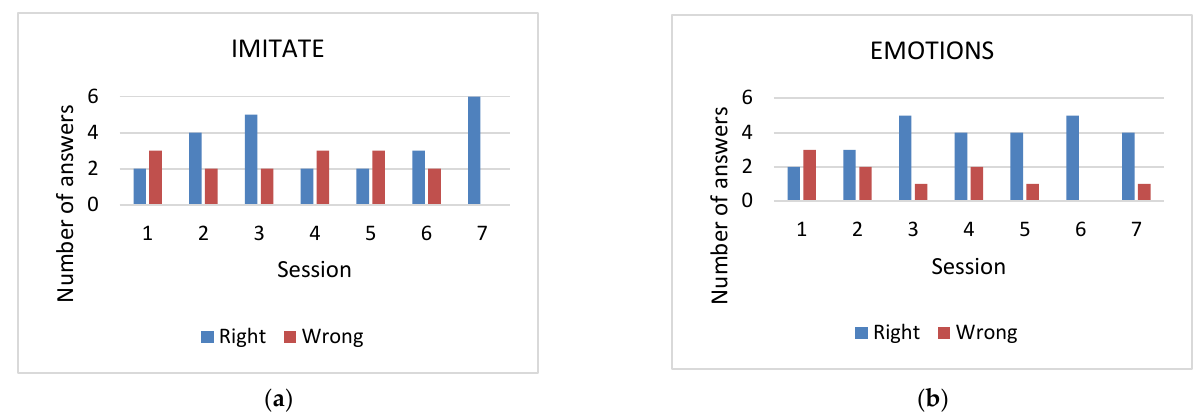
Figure 6. Child A results — On ( a ), the progress over seven sessions with the IMITATE activity. On ( b ), the progress over seven sessions with the EMOTIONS activity.